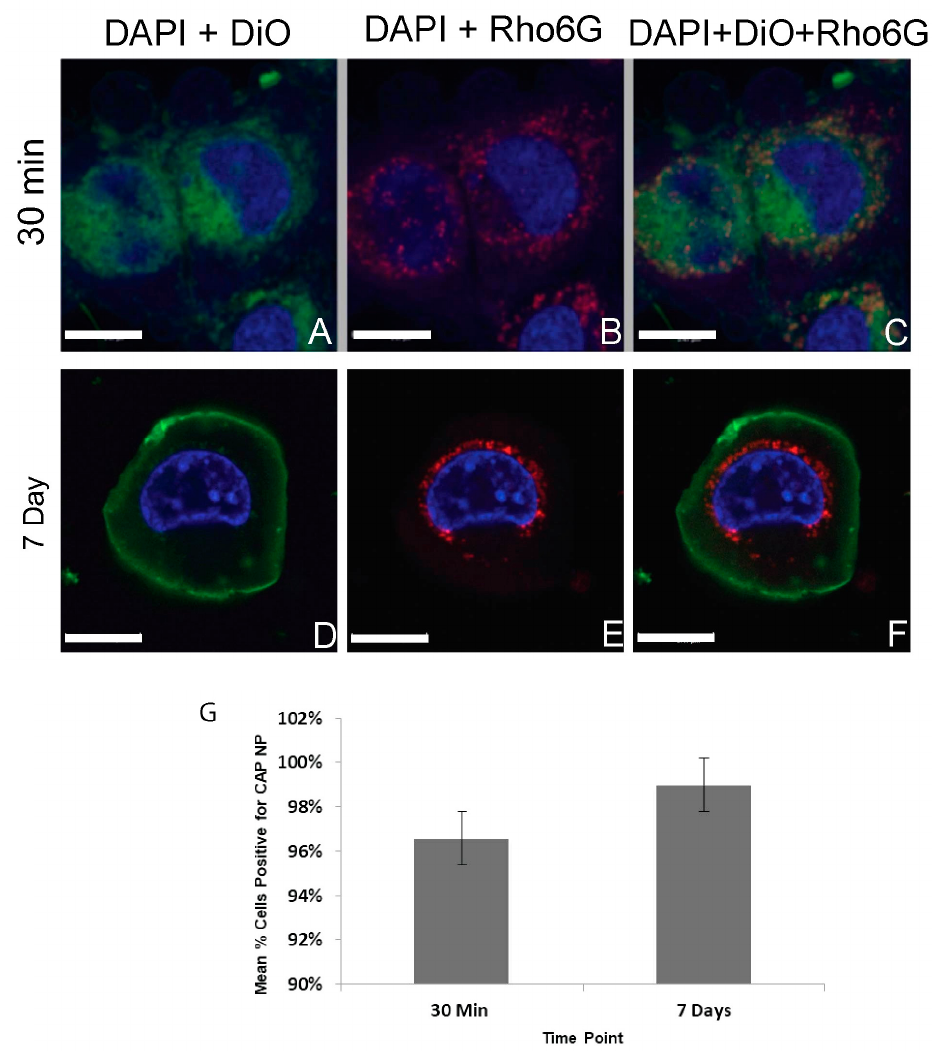
Figure 4. VK2/E6E7 vaginal epithelial cells treated with Rhod6G–CAP–NPs at (1 µg/mL) at: 30 min ( A – C ) and seven days ( D – F ) post-treatment. DAPI: Blue; DiO: Green; Rhodamine: Red. ( A ) DAPI + DiO; ( B ) DAPI + Rho; and ( C ) DAPI + DiO + Rho. ( G ) Mean percent VK2/E6E7 cells containing Rhod6G–CAP–NPs over time. 10× and 20× imaged on IBIF Leica TCS SP8 MP Confocal Microscope images analyzed in ImageJ ( n = 4). For visualization of nanoparticles in print, contrast and brightness were enhanced using imaging software. ( G ) The percentage cells with Rho6G–CAP–NPs over seven days. Error bars reflect standard error of the mean, and the mean percent of cells containing Rhod6G– CAP–NP at 30 min and seven days was not significantly different ( p > 0.05).